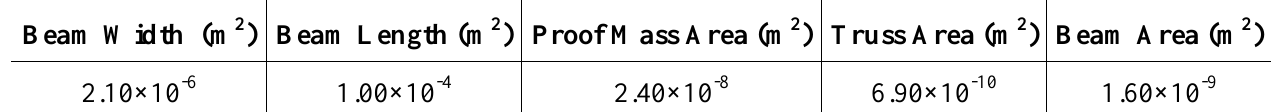
Table 2. Dimensions of the D